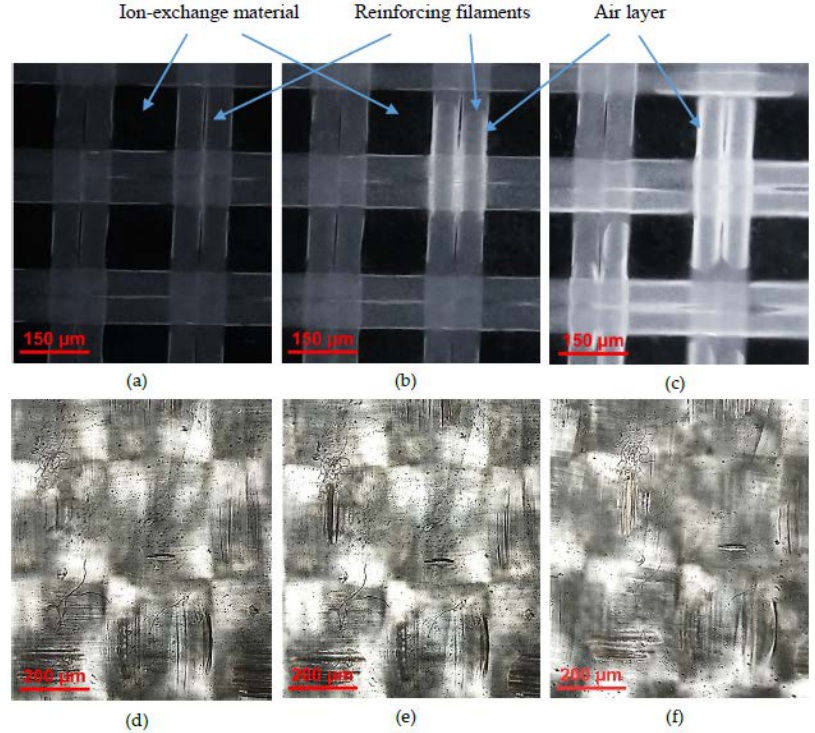
Figure 3. Optical microscope images with transmitted light of the surface of initially swollen CJMC-5 ( a – c ) and CMX ( d – f ) membranes after their contact with air for 5 s ( a , d ), 20 s ( b , e ), and 150 s ( c , f ).